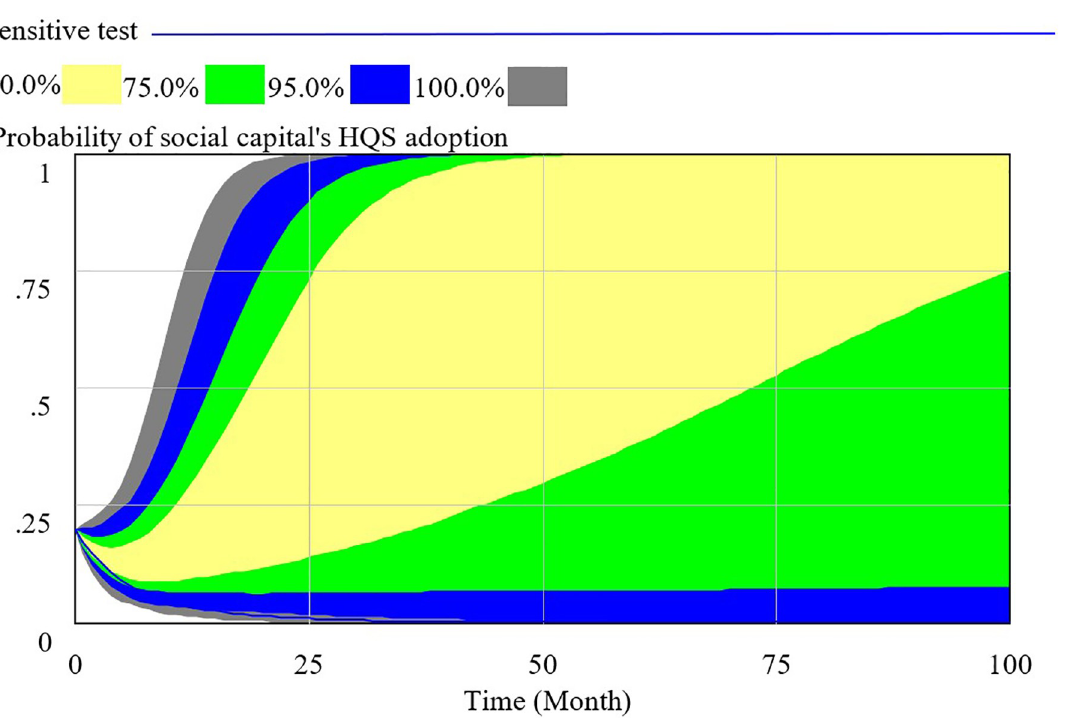
Fig 3. Sensitivity analysis of social capital’s strategy